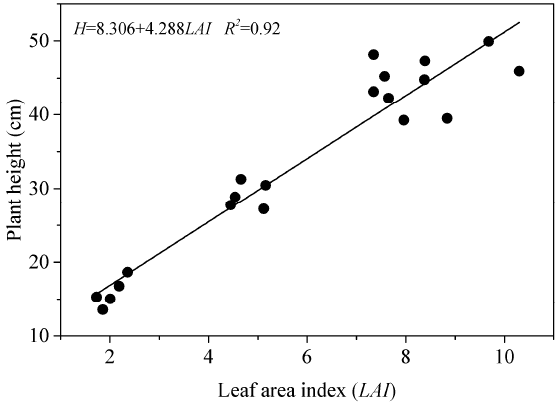
Figure 5. Relationship between plant height ( H ) and leaf area index ( LAI ).